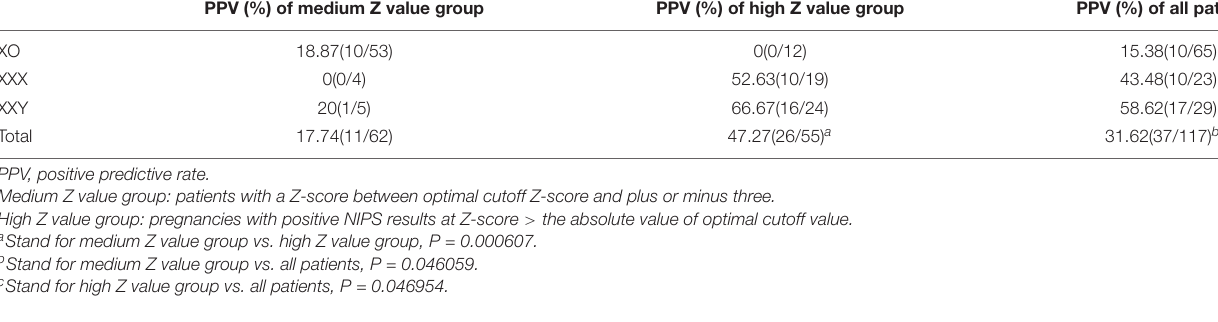
TABLE 6 | The PPV performance of XO, XXX, and XXY in different groups of Z-scores. PPV (%) of medium Z value group PPV (%) of high Z value group